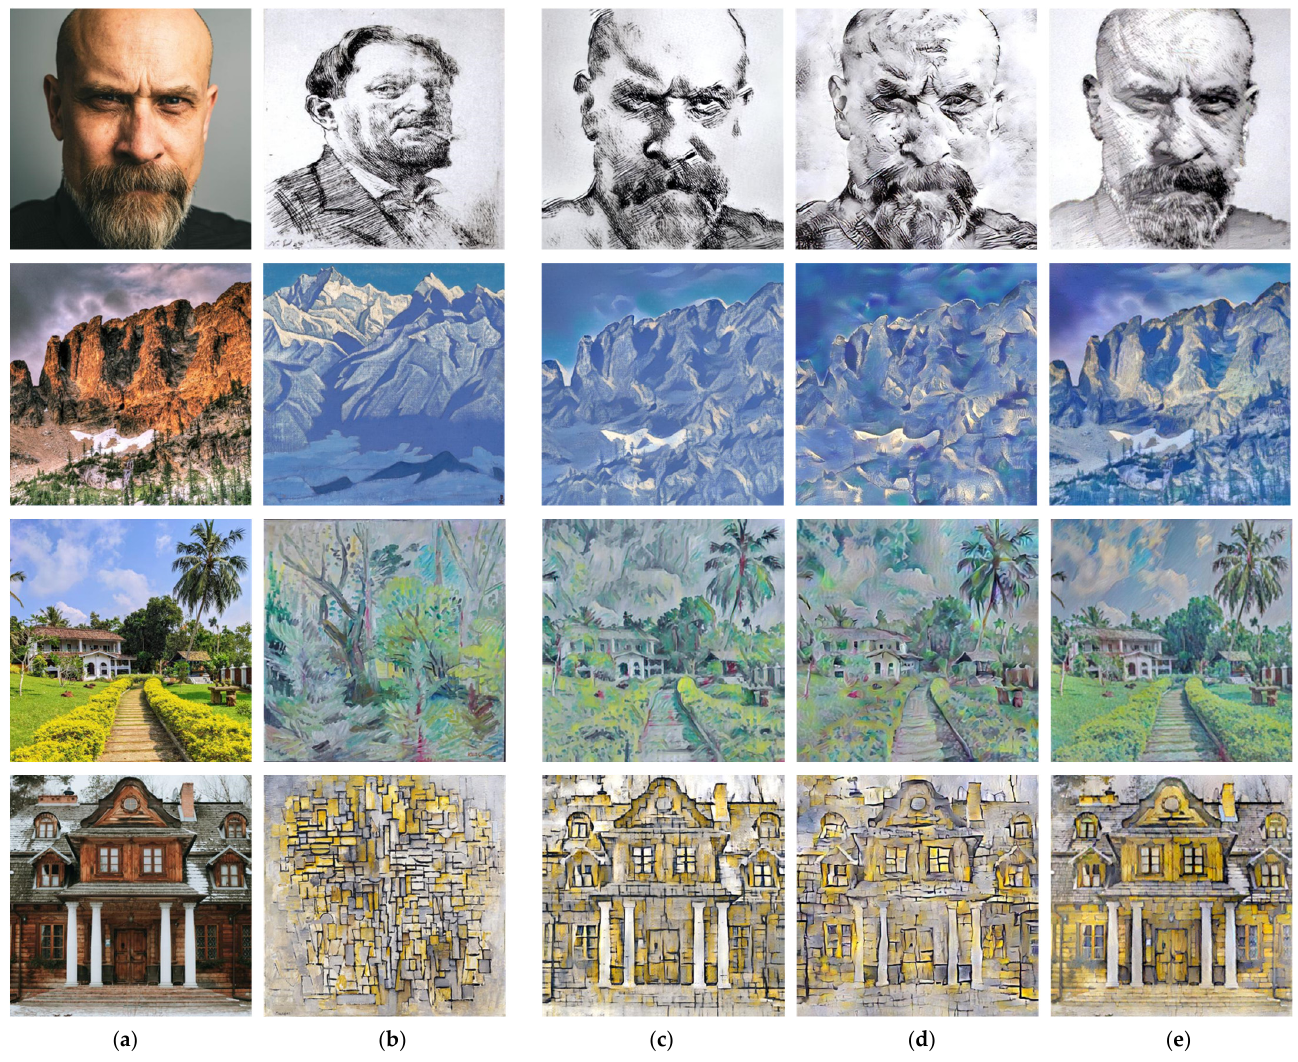
Figure 6. Qualitative comparisons between our method, WCT [6] and STROTSS [2]: ( a ) The content images; ( b ) The style images; ( c ) The stylized images are generated by our method; ( d ) The stylized images are generated by WCT; ( e ) The stylized images are generated by STROTSS.